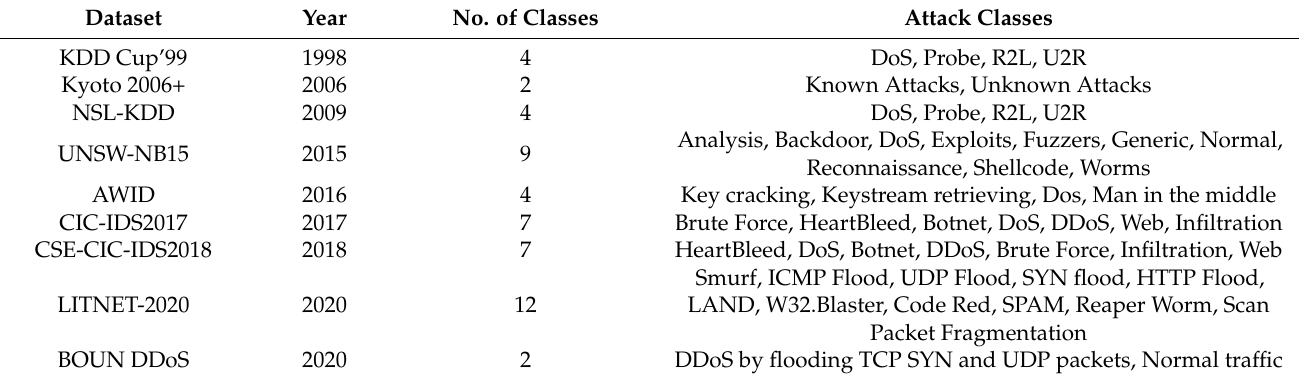
Table 1. Summary of publicly available benchmark network-based intrusion